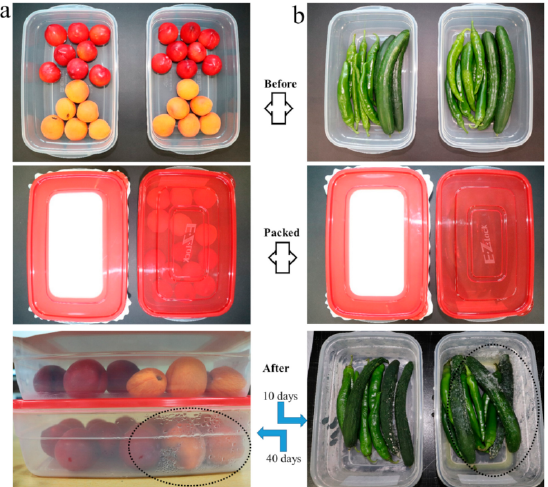
Figure 7. Real time observatory experiments for suitability of nanofibers based food packaging ( a ) for fruits up to 40 days and ( b ) for vegetables up to 10 days; relative humidity was 75% at 2 ◦ C temperature (containers with red translucent lids are plastic based, while white lids represent nanofibers based